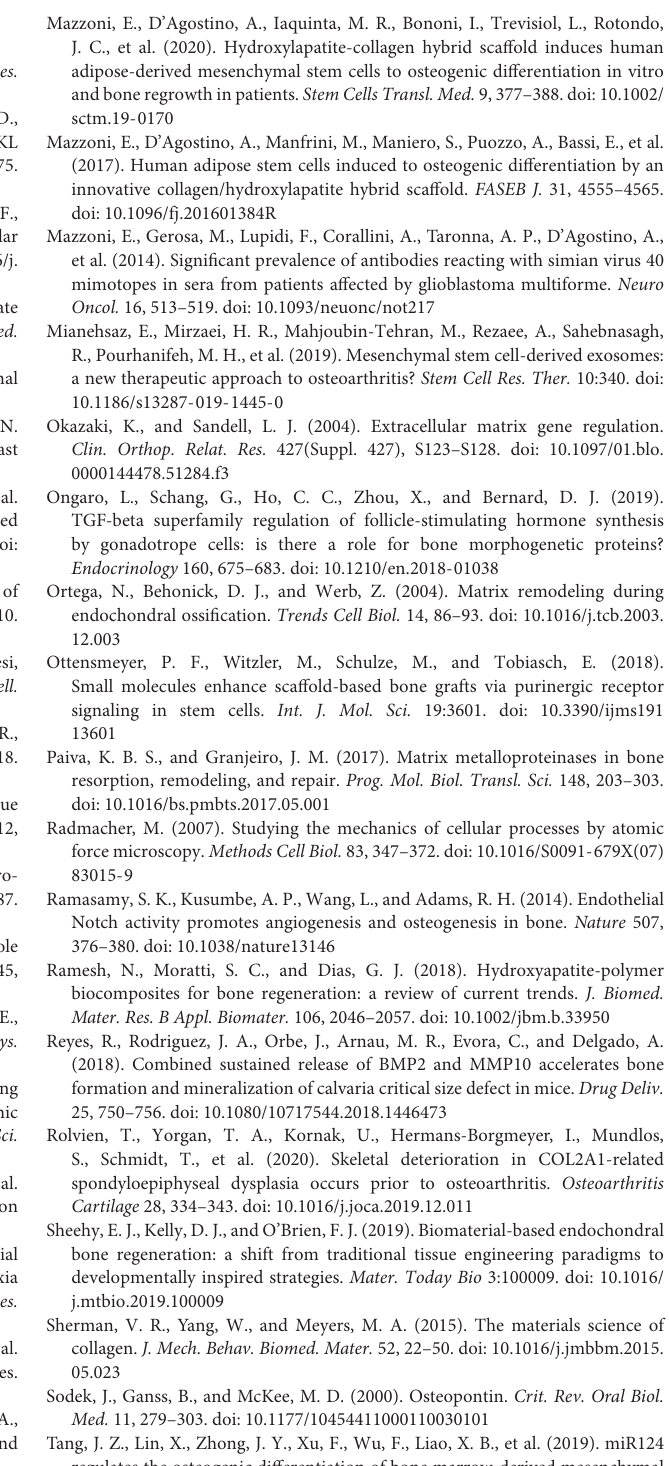
(B) HBMC cytoskeleton analysis by phalloidin TRITC (tetramethylrhodamine isothiocyanate) staining; (C) Cellular nuclei stained with 0.5 mg/ml DAPI; (D) Cytoskeleton analysis of hBMCs, expressing eGFP, by phalloidin TRITC